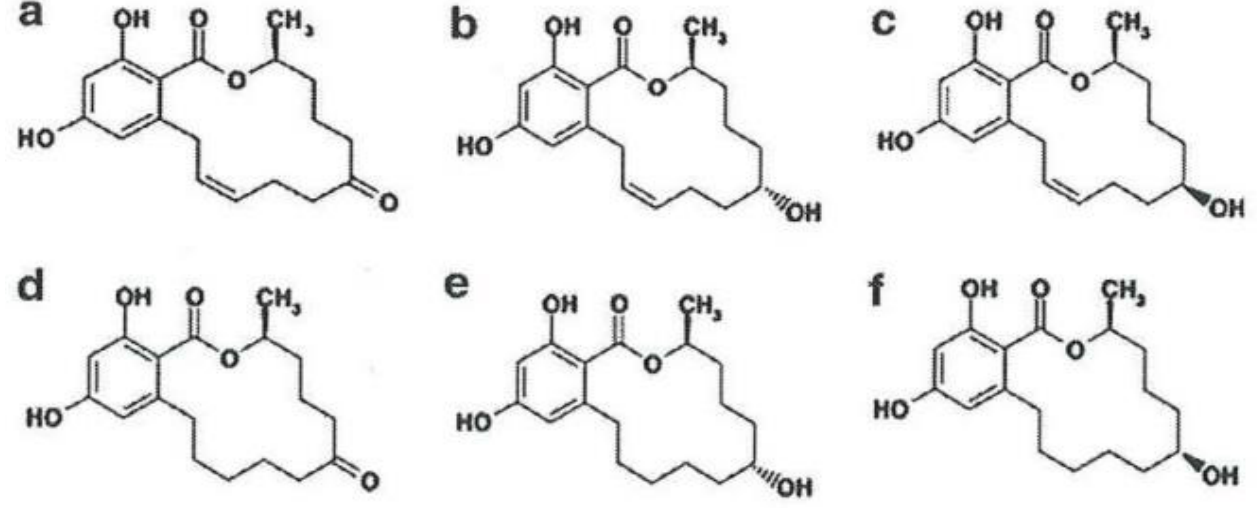
Figure 1. Chemical structures of zearalenone and its derivatives: a) zearalenone (ZEA), b) α-zearalenol (α-ZOL), c) β-zearalenol (β-ZOL), d) zearalanone (ZAN), e) α-zearalanol (α-ZAL), f) β-zearalanol (β- ZAL) (19